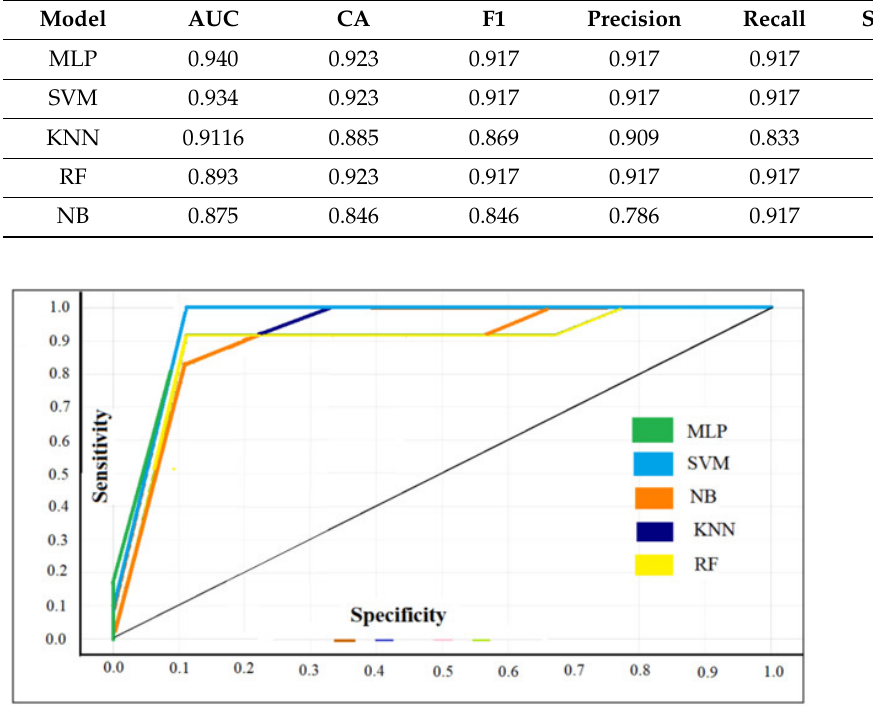
Figure 13. The area under ROC curve (AUC) for the five models.